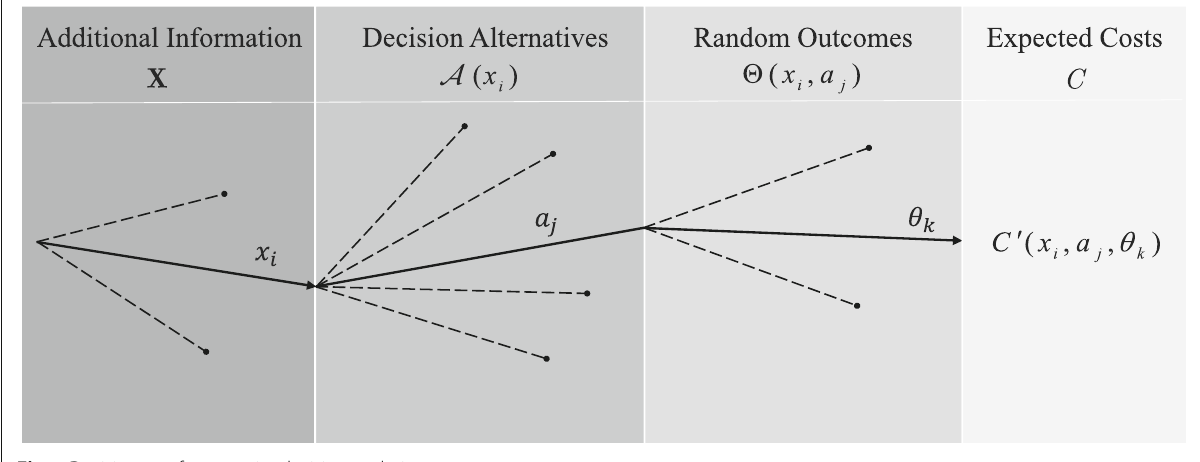
the potential benefits associated with collecting the addi- tional information are referred to as the expected value of information (EVI), which can be calculated by: